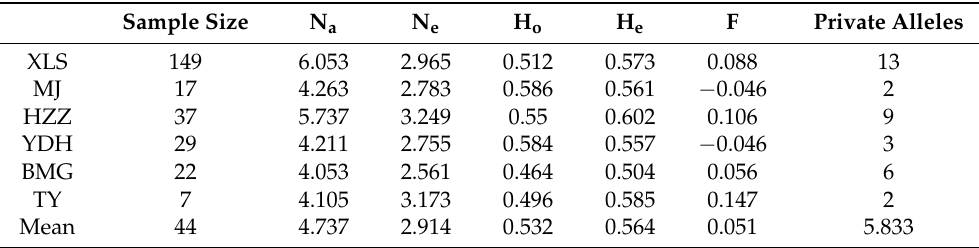
Table 3. Genetic diversity assessment of six populations based on 19 expressed sequence tag-derived simple sequence repeat (EST-SSRs).